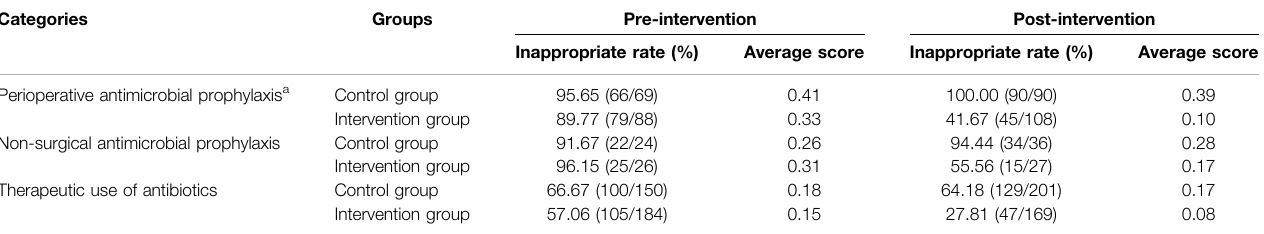
TABLE 5 | Inappropriate rate of antibiotic prescriptions and average score for both groups during the pre-intervention and post-intervention periods. Categories